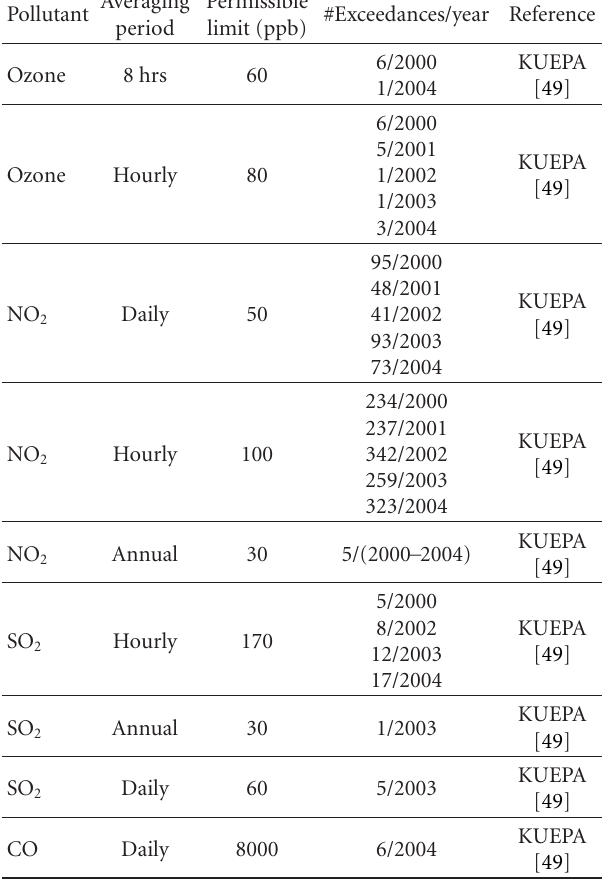
Table 4: Exceedences against KUEPA rules and regulations reported in Al-Mansoriah over the period between 2000-2004. Source: Al- Salem et al.